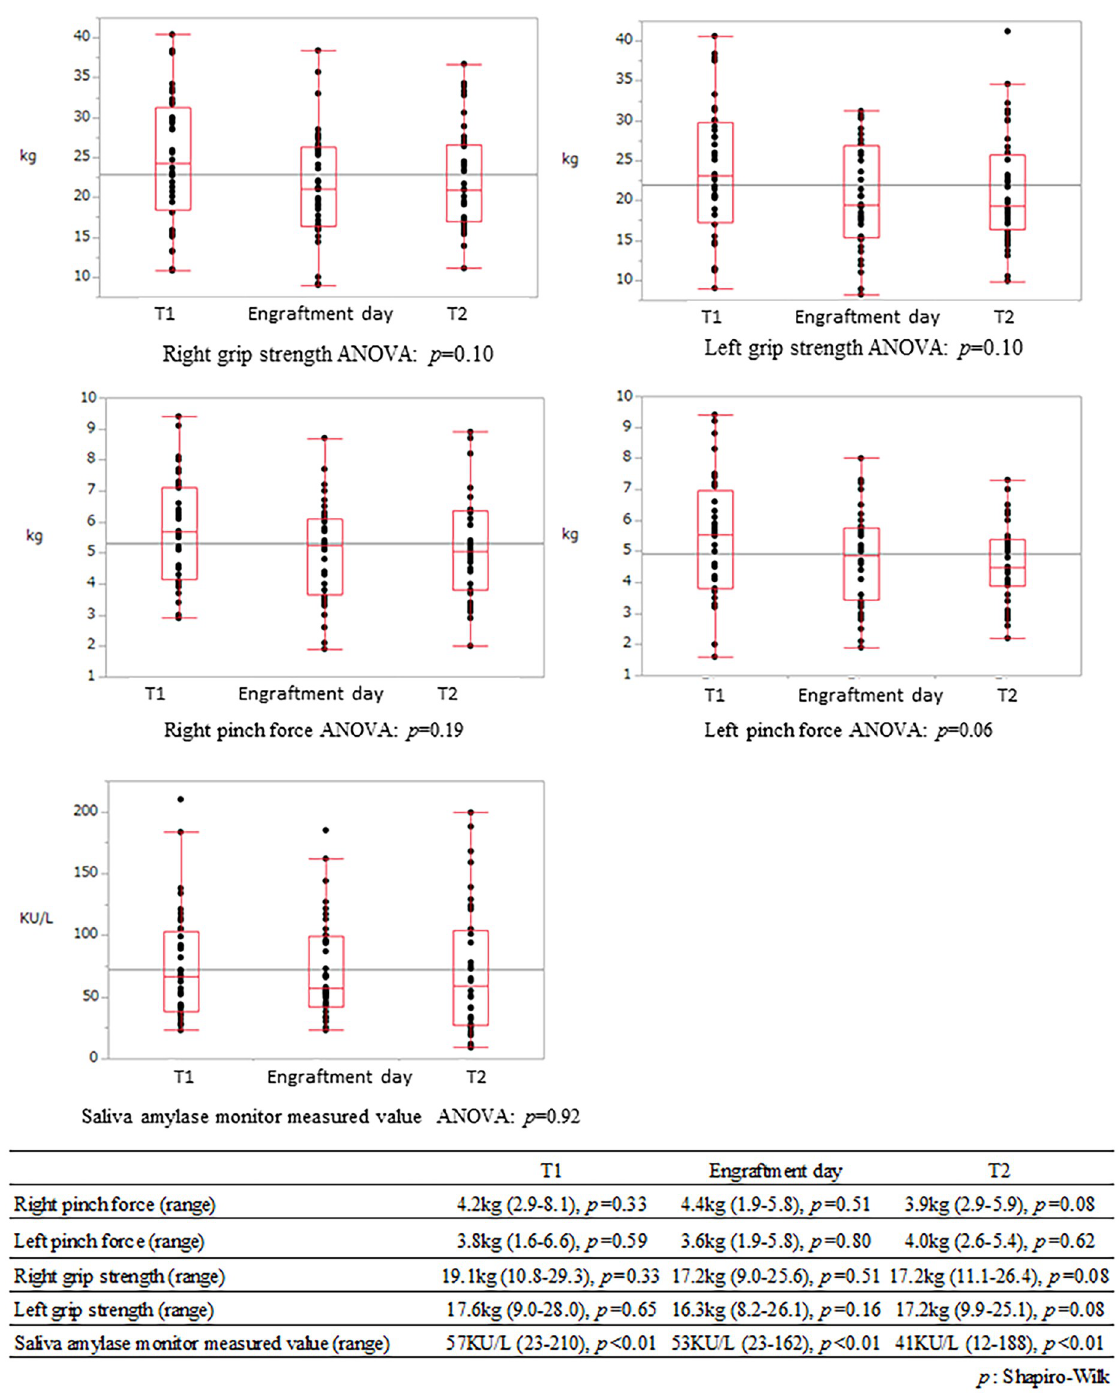
Fig 4. Grip and pinch strength and salivary amylase activity values at T1, on the engraftment date, and at T2. Lower right photo: Left, grip strength meter; upper right, salivary amylase monitor; lower right, pinch strength meter.